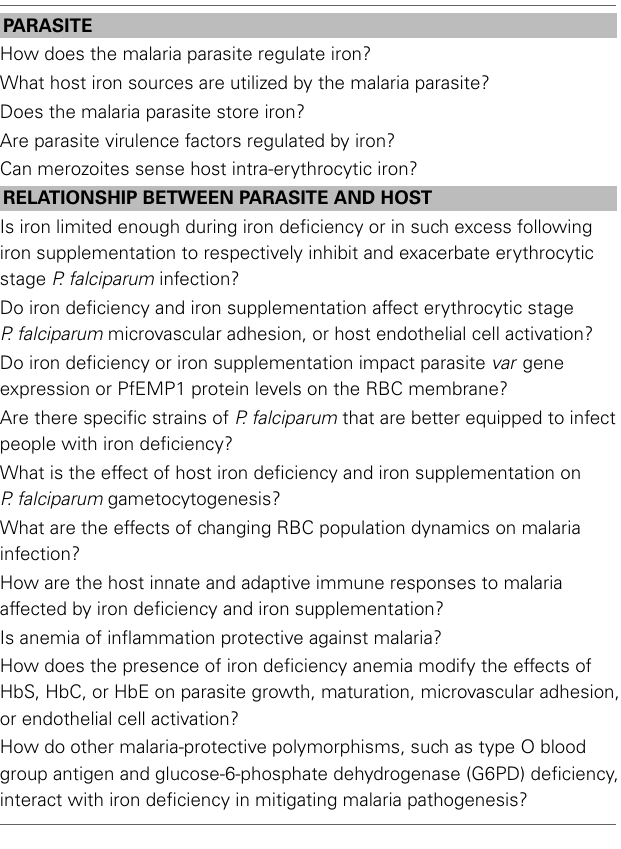
Table 4 | Questions for future translational